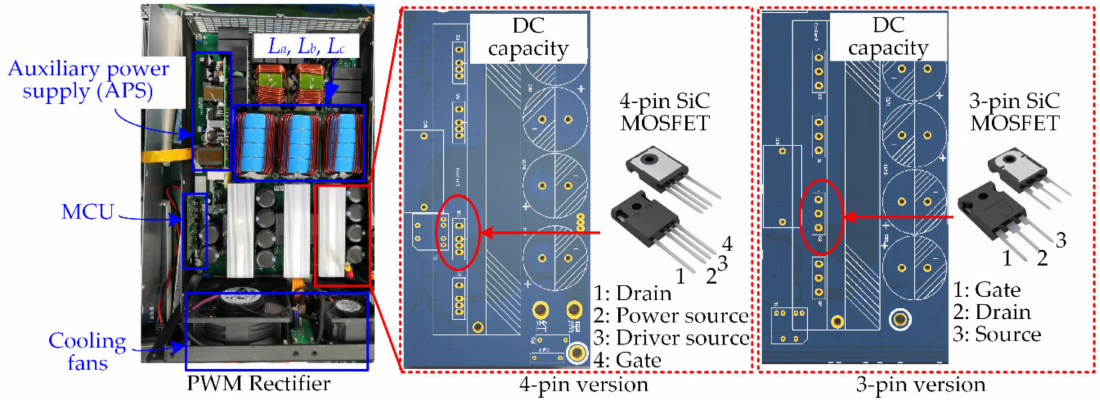
Figure 7. Experimental device for all-SiC MOSFET PWM